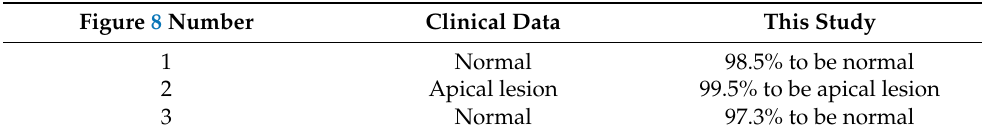
Table 6. Result after judgement for Figure 8 sample image.